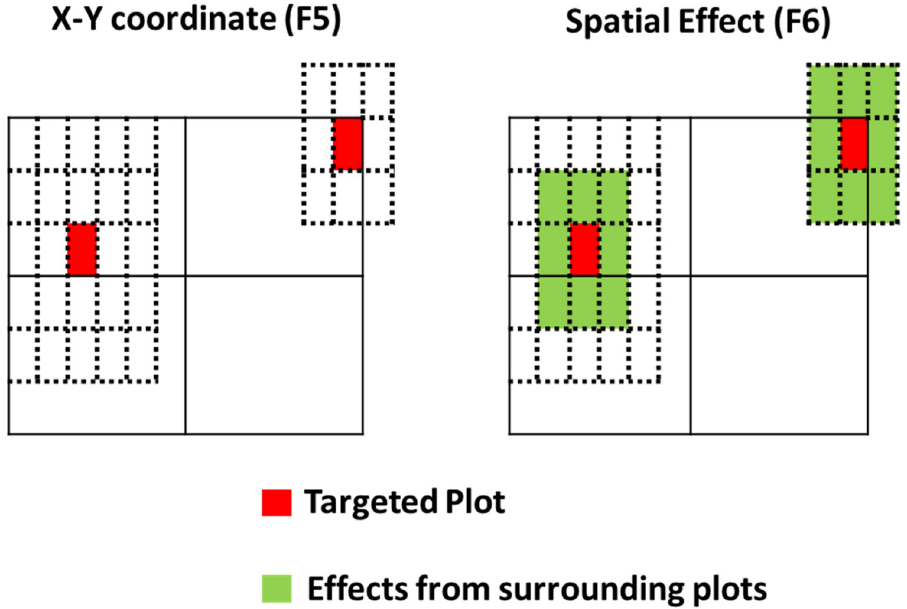
Fig 2. Illustration of spatial effects employed in the F 5 and F 6 test. In the F 5 test, we fitted X- and Y-coordinates as the spatial effect in the model, whereas for the F 6 test, we included its eight surrounding plots as well in the spatial effect (as a moving average). The figure was adapted from and originally drawn by Andrea Bellucci (pers. comm.).